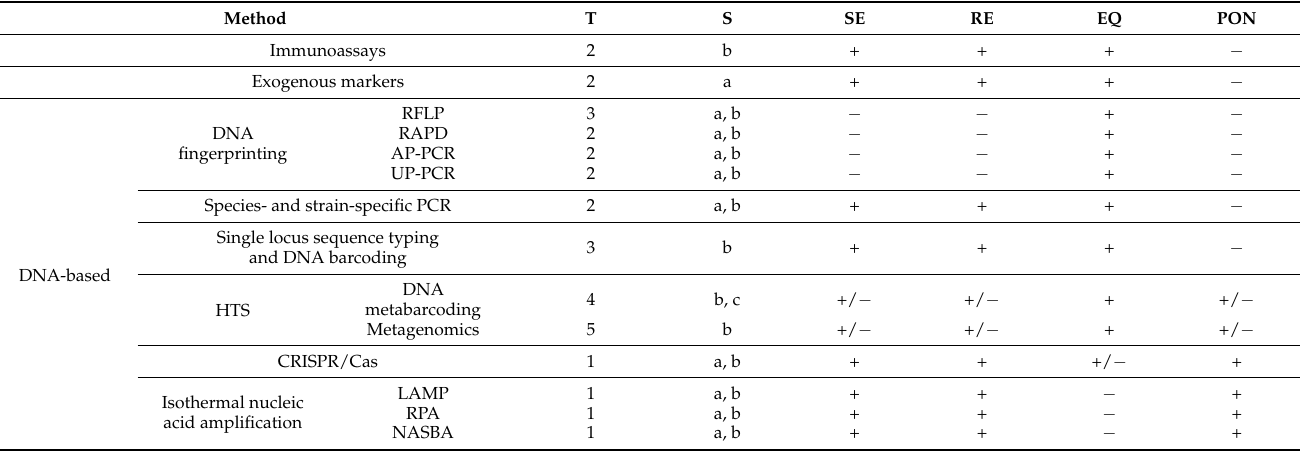
Table 1. Evaluation of available molecular methods potentially applicable for detection and monitor- ing of Trichoderma species/strains in edible mushroom